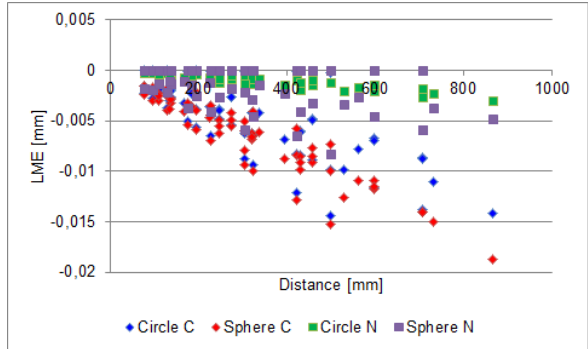
Figure 15: Length measurement errors for VDI set-up of circular targets In the case of parallel viewing directions (normal case of stereo photogrammetry) the LMEs are significantly smaller (Circle N, Sphere N). The maximum LME reaches 0.007mm, hence below a significant level. It can be assumed that the points of the scale bars are subject to similar systematic point errors that